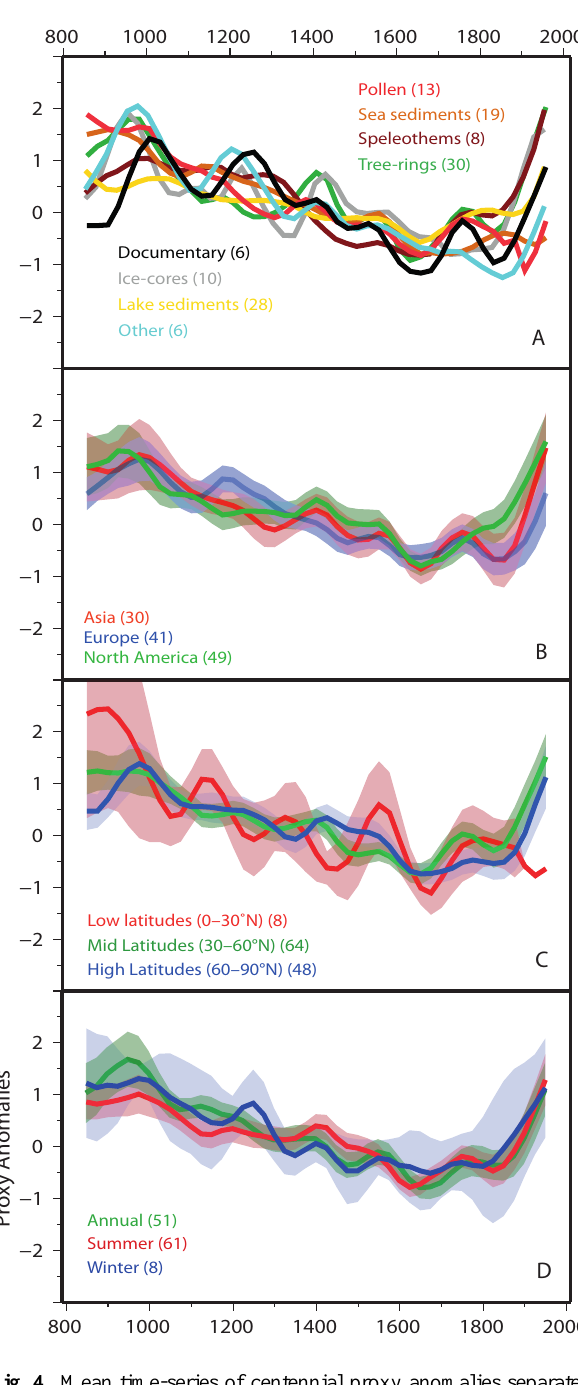
Fig. 4. Mean time-series of centennial proxy anomalies separated by: (A) data type, (B) continents, (C) latitude, (D) seasonality of signal. The curves in (B–D) show the mean and moving block bootstrap confidence intervals ( ± 2 standard error) (Wilks, 1997). The numbers in parentheses indicates the number of proxies in each